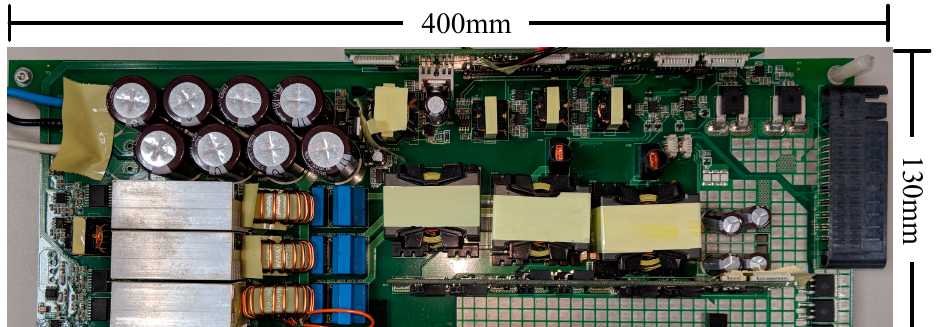
Figure 24. Efficiency of three-phase wye–delta LLC.